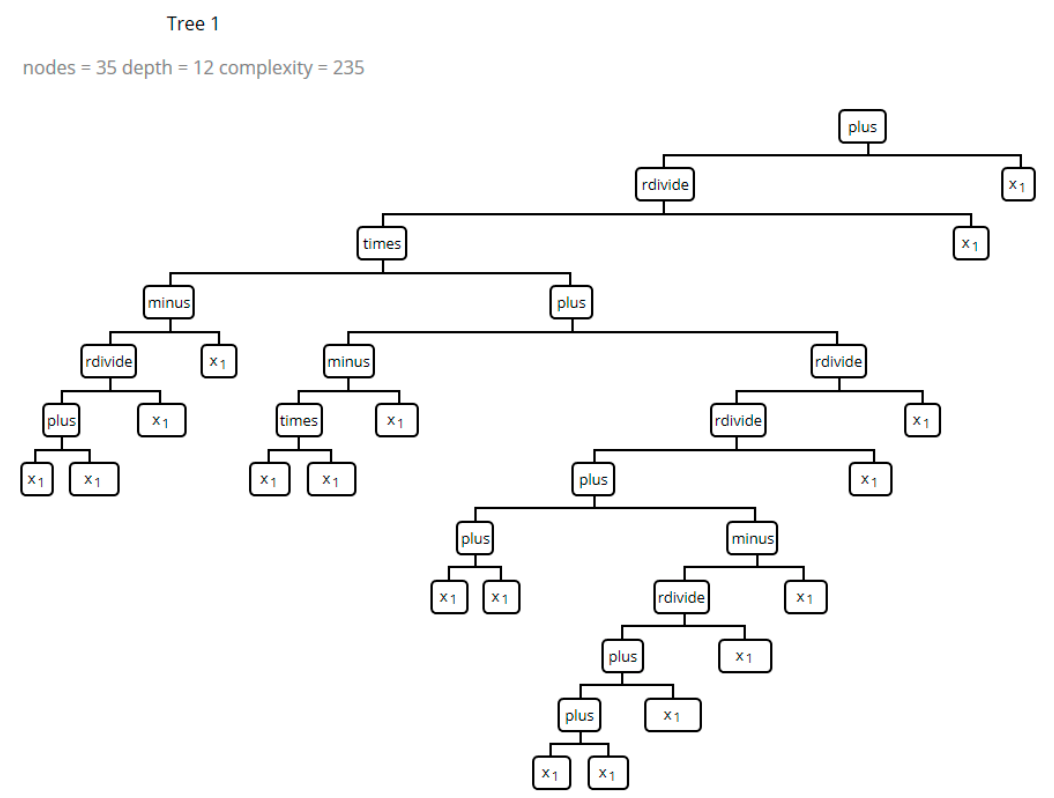
Figure 6. MGGP example output.